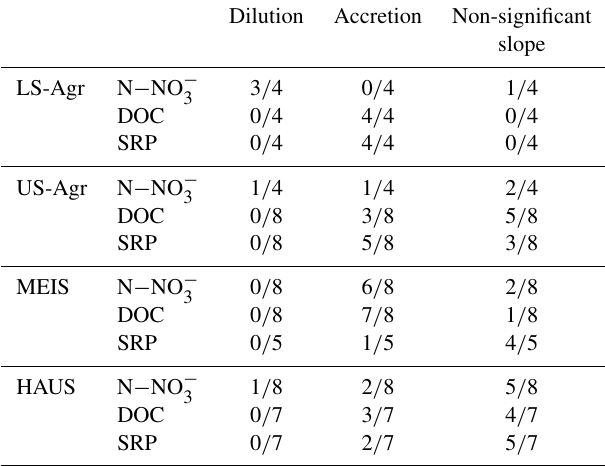
Table 4. Counting of accretion and dilution patterns during storm events derived from the slope of concentration–discharge relation- ships ( p < 0 .